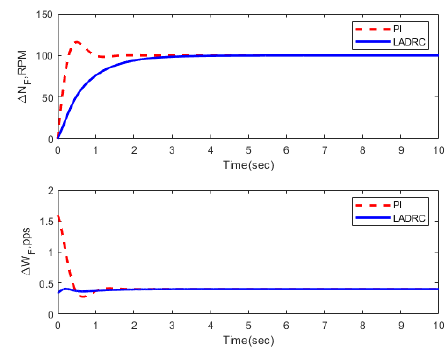
Figure 20. Step response of FC11.